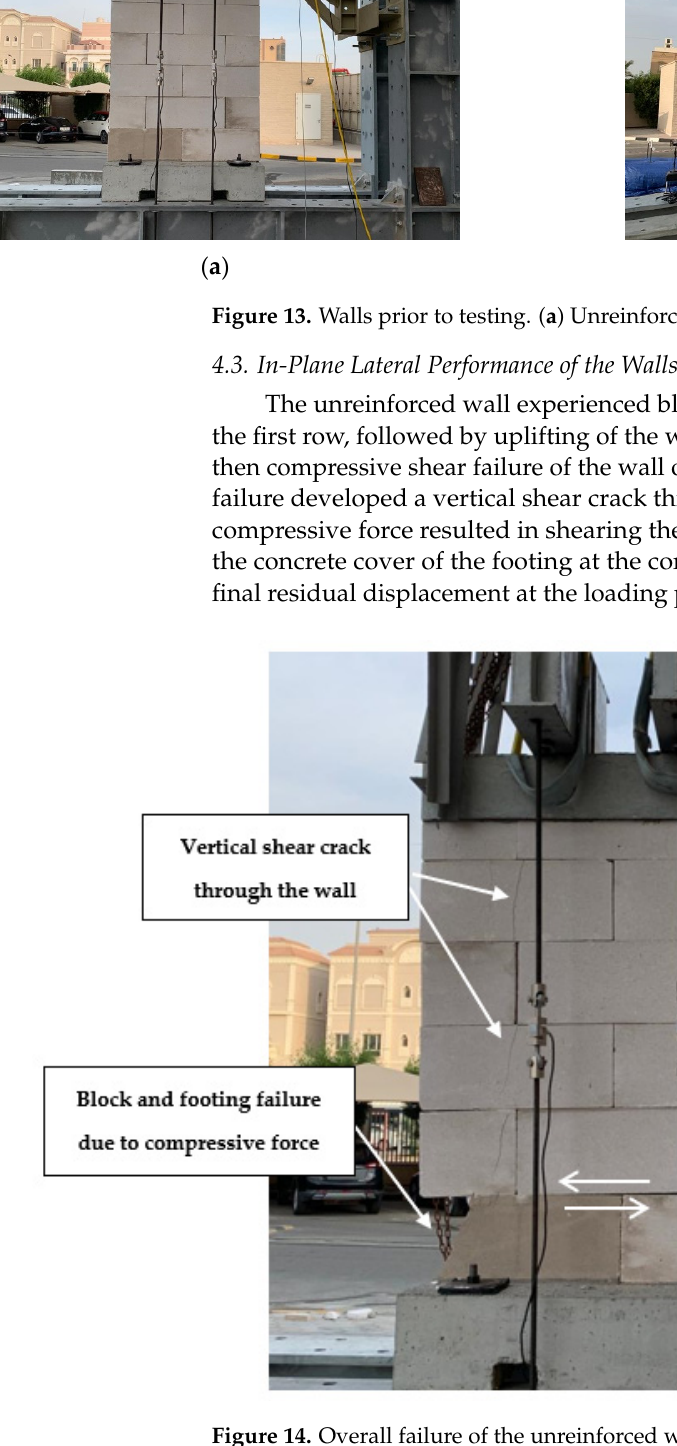
10 of 17 Figure 12. Installation of the CFRP laminates with epoxy resin. The wall reinforcement methodology provided a more practical approach than plac- ing full vertical reinforcing bars in the wall. Vertical wall reinforcement had always been challenging as it requires the bar placement with its full length, and then the placement of the hollowed blocks through these bars, which causes delays to the construction process. In the proposed methodology, hollowed blocks are only placed at the first two layers. Afterwards, the CFRP reinforcement is externally applied after the completion of the wall construction. Figure 12 shows the installation of the CFRP sheets to the wall after the con- struction was completed. The vertical sheets were laminated first and then the horizontal sheets. 4.2. Large-Scale Test Setup The two walls were tested using a hand-operated hydraulic jack that applied the load